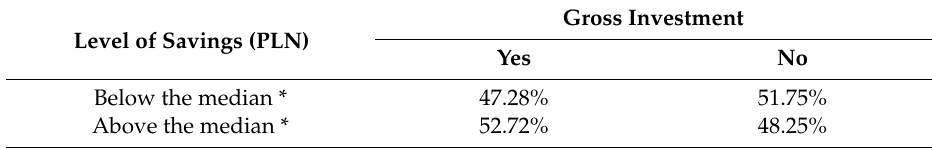
Table 5. Gross investments and the level of generated savings of small agricultural holdings in Poland. Gross Investment Level of Savings (PLN) Yes No Below the median * 47.28% 51.75% Above the median * 52.72%